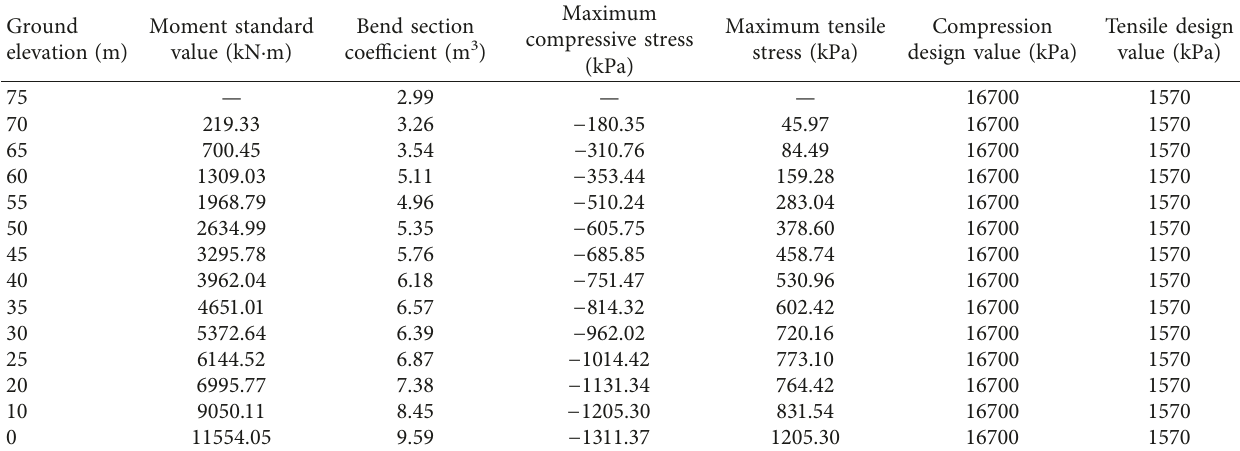
Table 8: Maximum stress values under the action of a horizontal earthquake.